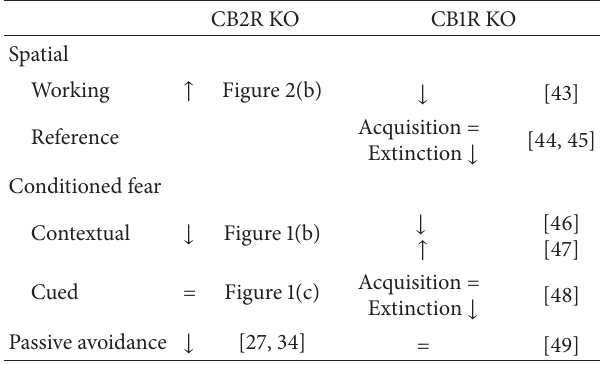
Table 1: Changes in memory of cannabinoid receptor KO mice. Changes in various types of memory of CB1R KO and CB2R KO mice, compared with WT mice, are summarized from our current results and other studies. Spatial working memory was assayed in